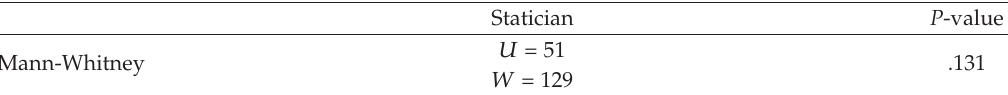
Table 9: Statistics of